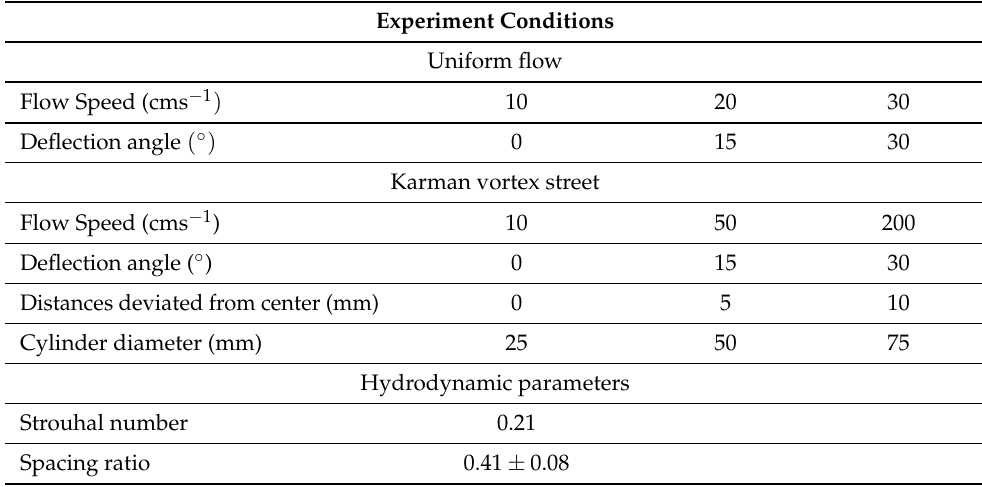
Table 1. Simulation experiment conditions and hydrodynamic parameters.